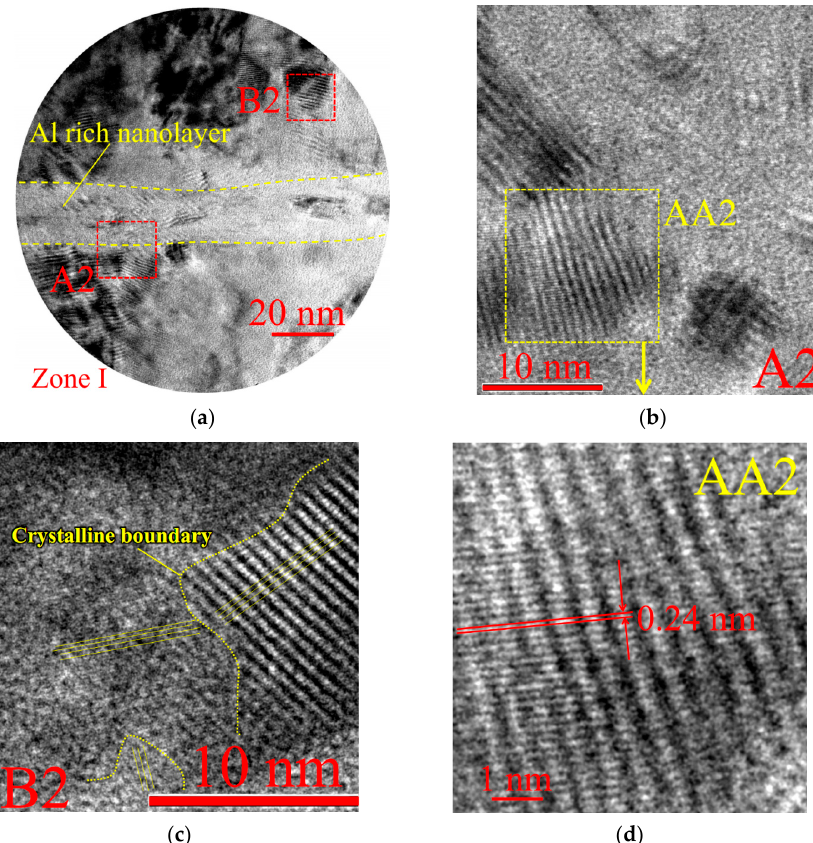
Figure 7. Nano-structure of the wear-resistant (Ti,Al,Si)N layer of the coating (sample S4) (TEM). General view of the nanolayer with a high aluminum content (light contrast on TEM) ( a ); area A2 ( b ); area B2 ( c ); crystalline planes ( d ).